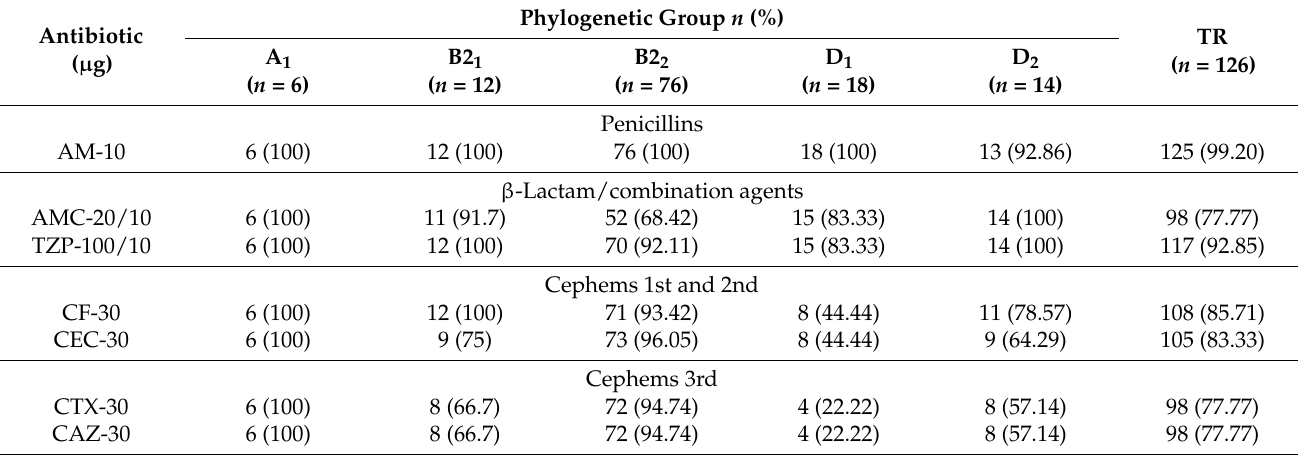
Table 1. Resistance to 10 antibiotic categories and ESBL production of 126 UPEC O25b clinical strains.